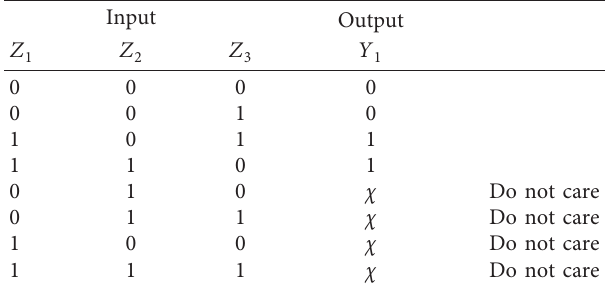
Figure 6: ANN can implement the Boolean expression Z Z Z + Z Z Z . The neurons are configured to implement the 1 2 3 1 2 3 NOT, the NAND, and the connecting line. In general, the neurons have more inputs. While the weight of inputs is 0, the outputs are not affected, which are not drawn. Table 2: Example of a truth table.